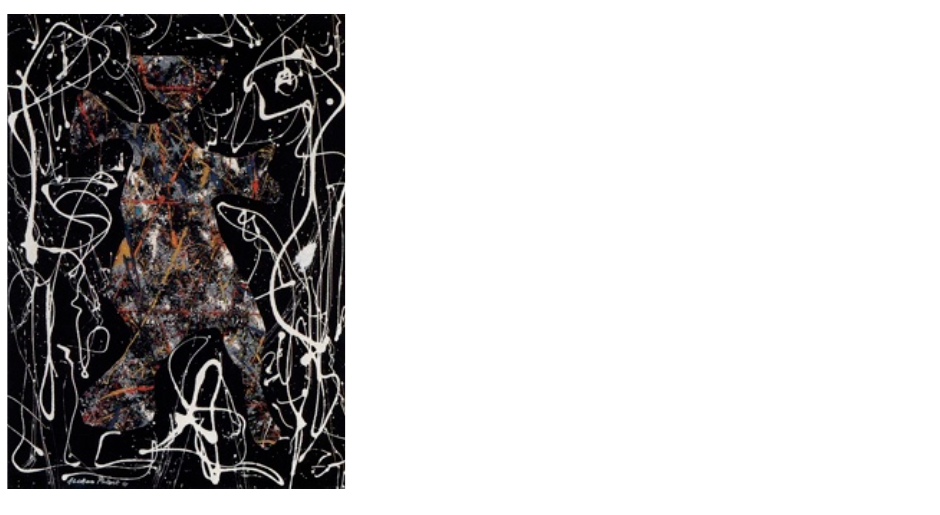
terized by an encrusted surface and angular throws of multi-colored paint, presumably a failed work. From the unity of this field, he cut out a large humanoid figure. This figure he then collaged onto the vertical axis of another surface, the black ground of which he articulated with white poured lines, suggesting upright personages flanking it to the left and right. These white poured lines challenge the central figure, which appears to be sexless, with their more instinctual energies, an echo of the similar challenge made in Male and Female where sexy automatist energies swirled around the as yet untransformed